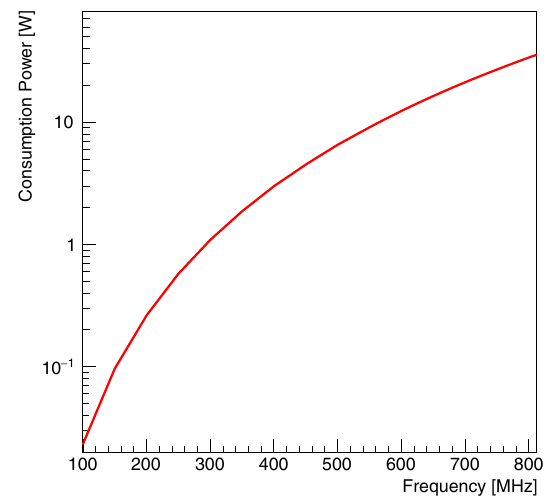
FIG. 2. The ohmic loss of Nb superconducting RFQ (SC-RFQ) as a function of the resonant frequency. The ohmic loss was evaluated by the lumped circuit model with a RFQ length and intervane voltage of 3.1 m and 80 kV, respectively, similar to those of J-PARC. The ohmic loss of SC-RFQ was calculated using Eq.